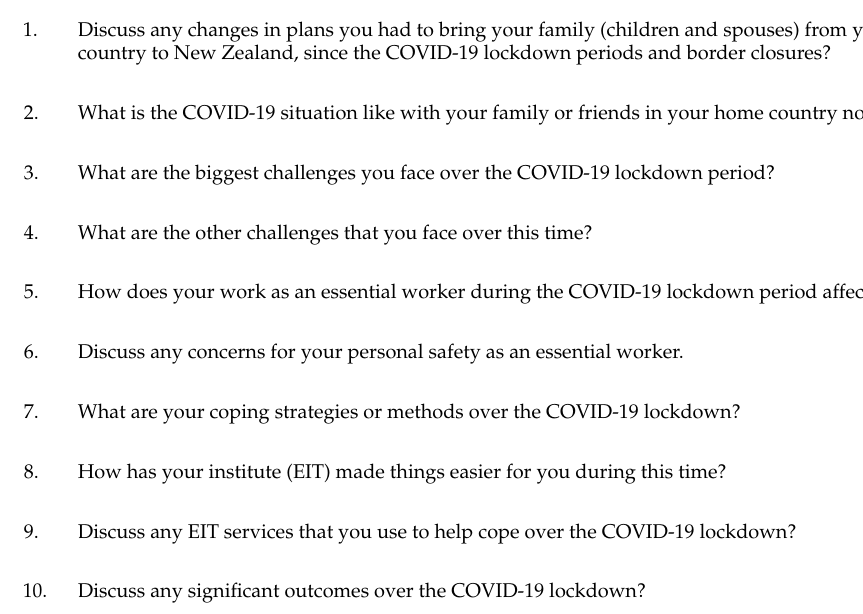
Table 2. Semi-structured interview guided